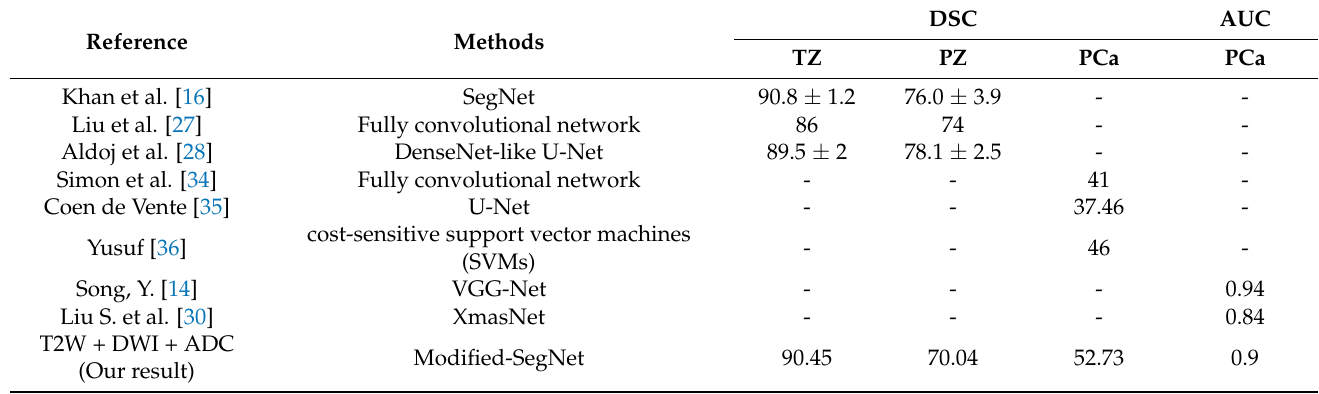
Table 4. Performance comparison of the network with state-of-the-art